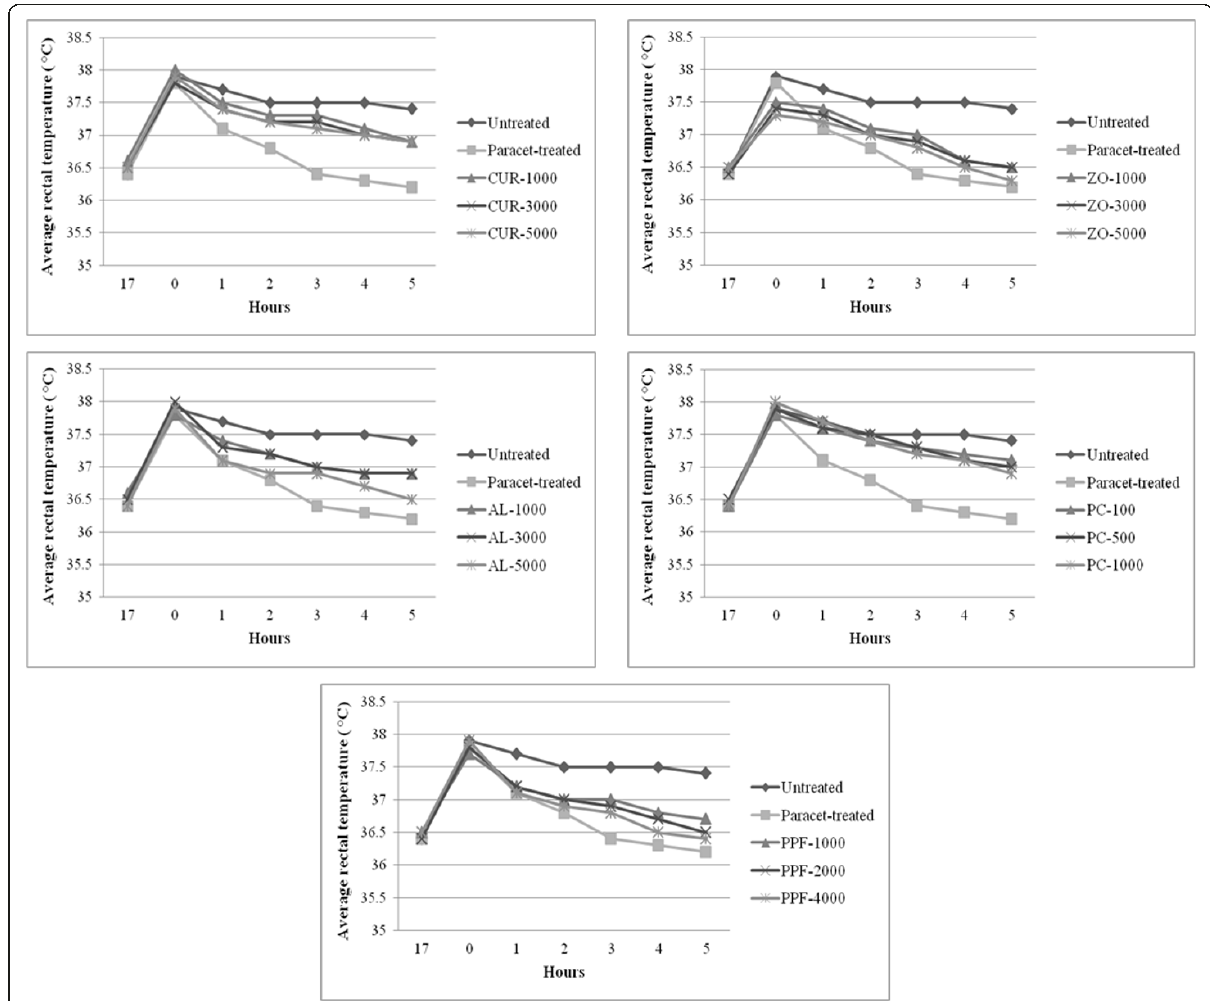
Figure 11 Antipyretic activity (represented by mean ± SEM of rectal temperature in brewer ’ s yeast induced pyrexia test) of CUR compound and extracts of ZO, AL, PC, and PPF at various dose levels, in comparison with untreated control and omeprazole (reference control) . Statistically significant difference by ANOVA, followed by post hoc scheffe test: PPF-treated group at medium dose level vs. control group (p < 0.01). ZO-treated group at high dose level vs. control group (p < 0.01). PC-treated group at high dose level vs. control group (p < 0.01). PPF-treated group at high dose level vs. control group (p < 0.01). Aspirin-treated group vs. control group (p <